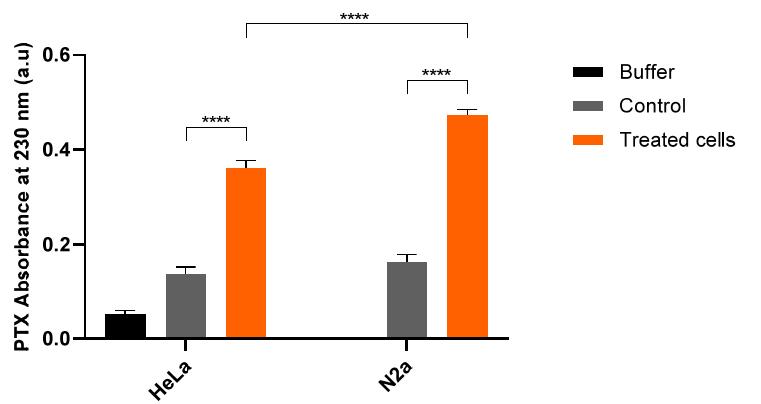
Figure 5. Measurement of PTX absorbance in Hela and N2a cancer cells 6 h after transfection mediated by PAMAM G4-PTX/pDNA/PEI complexes developed at N/P ratio of 50:2:1. The values were calculated with the data obtained from three independent measurements (mean ± SD, n = 3) and analyzed by two-way ANOVA followed by Bonferroni test.